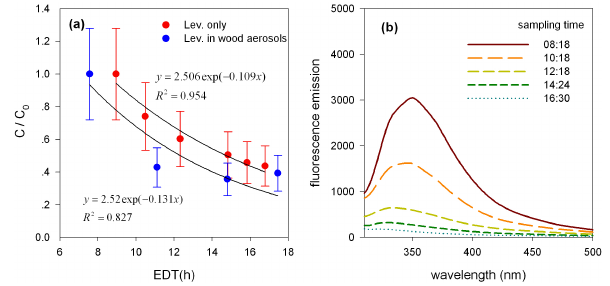
Fig. 4. (a) Time profile for the decay of pure levoglucosan (27 March 2013) and levoglucosan in wood smoke OA (21 November 2012). The concentrations of levoglucosan (C) were corrected for wall loss of particles and then normalized by the initial levoglu- cosan concentration ( C 0 ). The associated error with the measured concentration of levoglucosan by GC-MS is ± 20%. (b) Fluores- cence emission spectra of wood smoke particles collected at dif- ferent times on 21 November 2012. The excitation wavelength was 280nm.